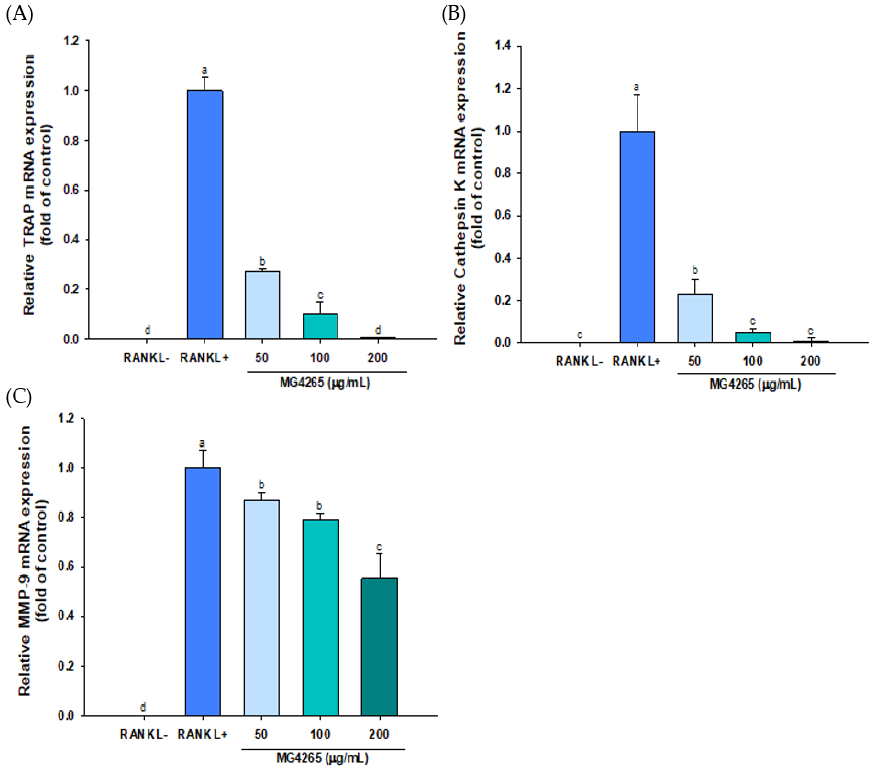
Figure 5. Effect of the SCS of L. salivarius MG4265 on osteoclast-specific ( A ) TRAP, ( B ) cathepsin K, and ( C ) MMP-9 mRNA expression in RANKL-stimulated RAW 264.7 macrophages. Different let- ters (a–d) indicate significant difference at p <